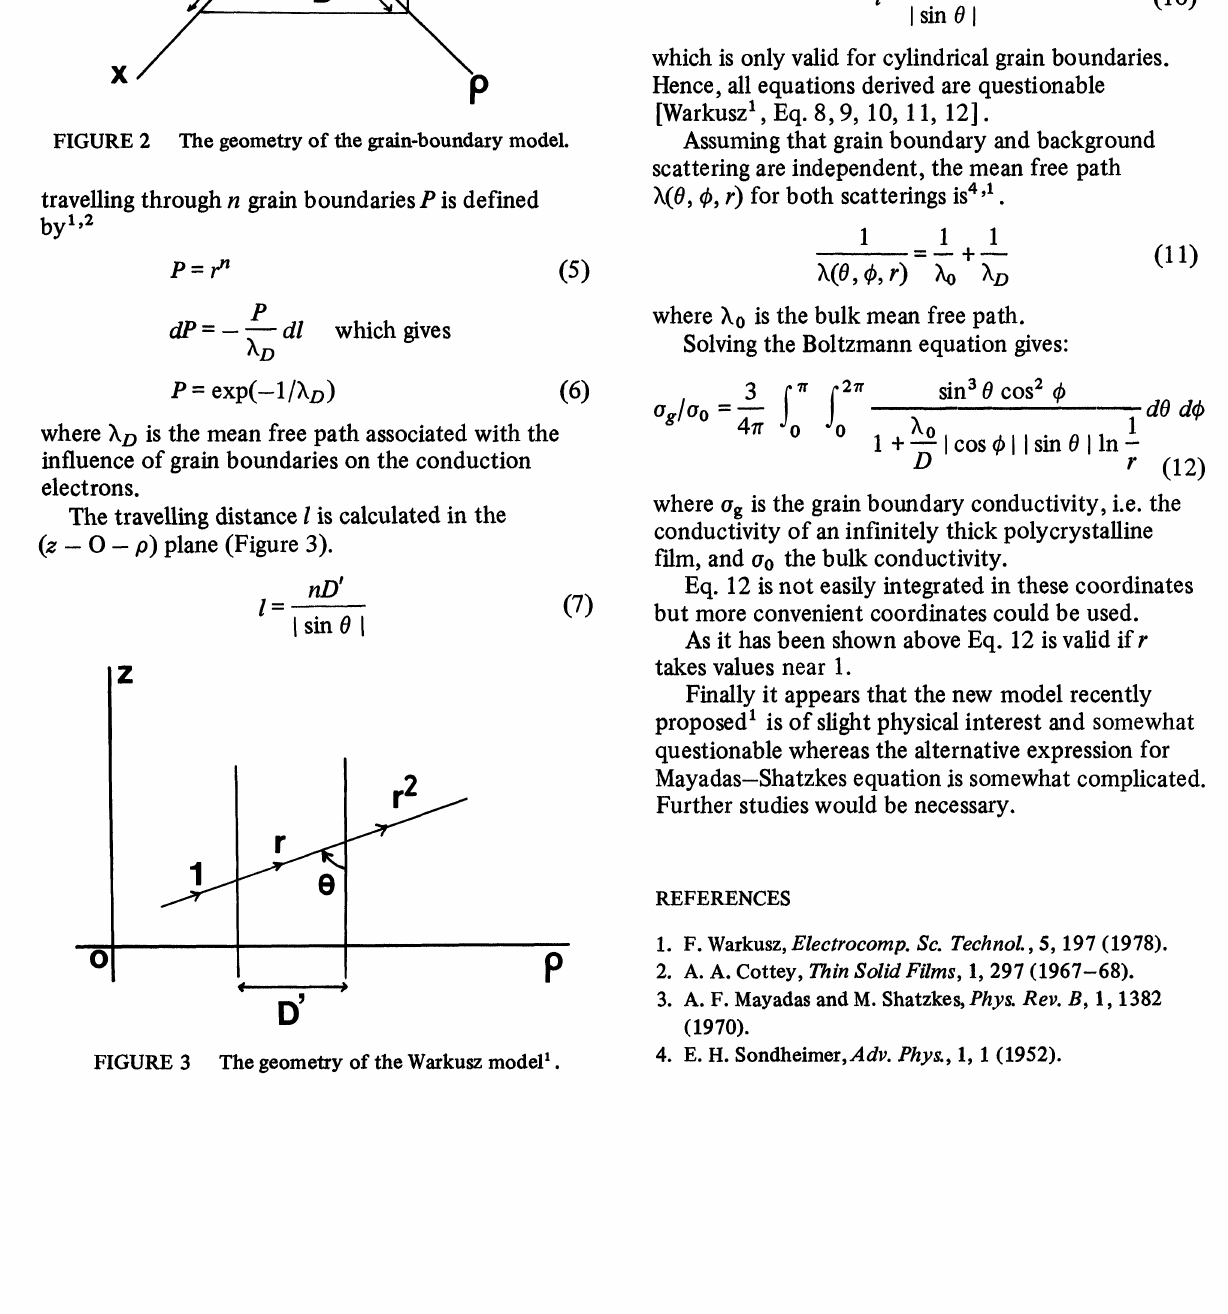
FIGURE 2 The geometry of the grain-boundary model.